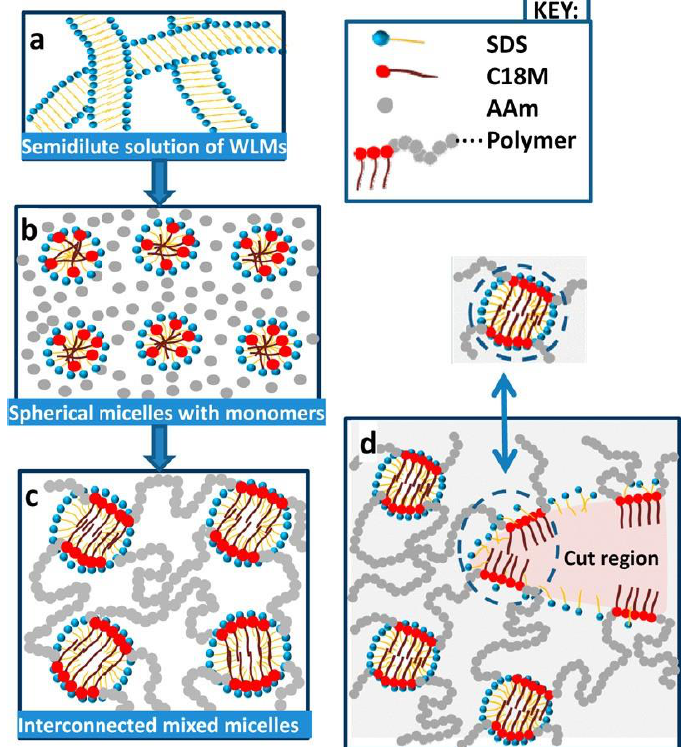
Figure 1. Formation of micellar hydrogels ( a – c ) and their self-healing mechanism ( d ). The double arrow in ( d ) indicates the gel region before and after healing. Reprinted with permission from reference [65]. Copyright 2016 American Chemical Society.